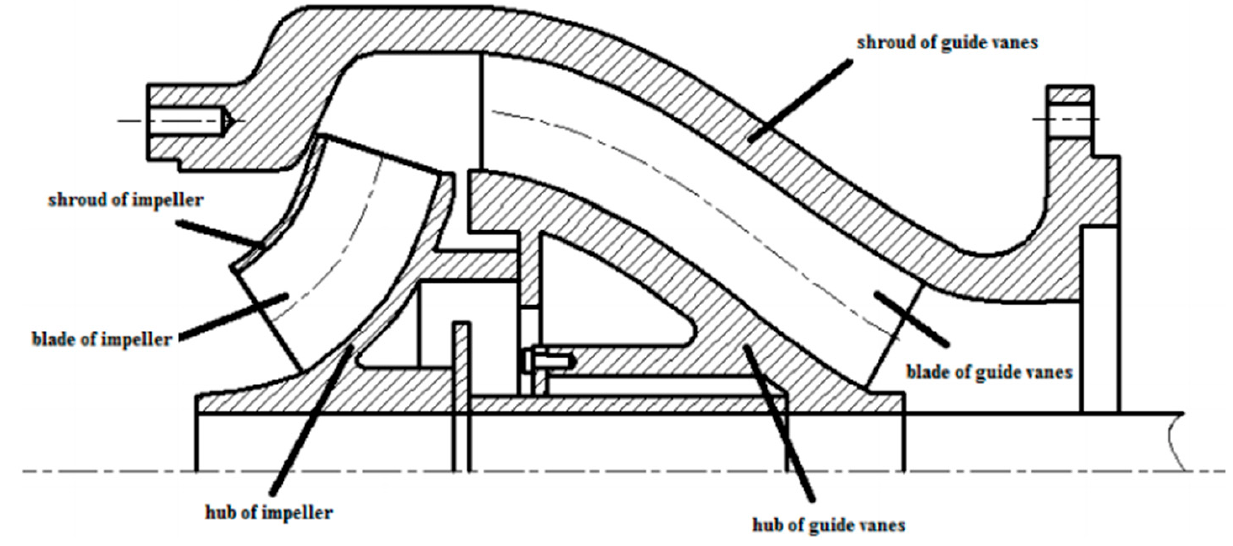
Figure 1. The structure of the through-passage components of the mining pump. The mining pump impeller designed has the geometric parameters shown in Table